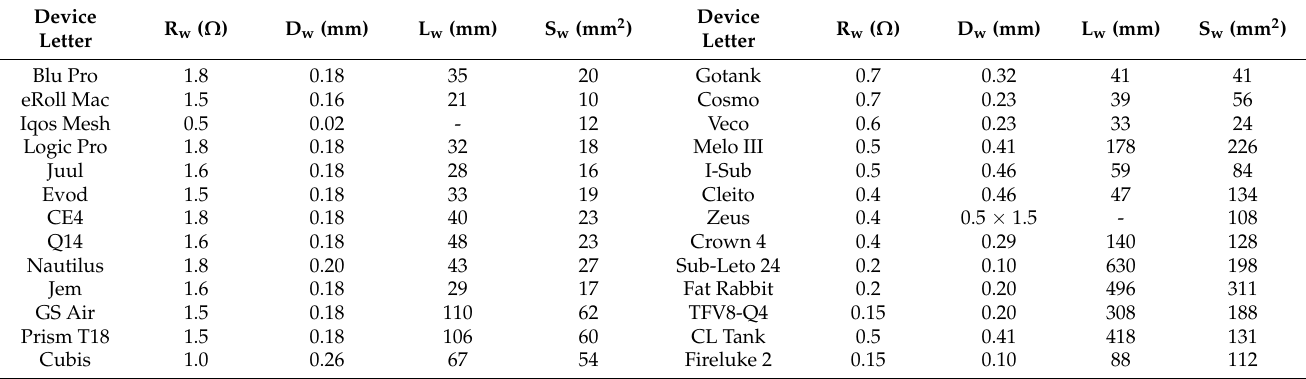
Table 5. Wire electrical resistance, diameter, length, and surface of the twenty-six devices tested design as a simple wire, parallel wires, Clapton, or